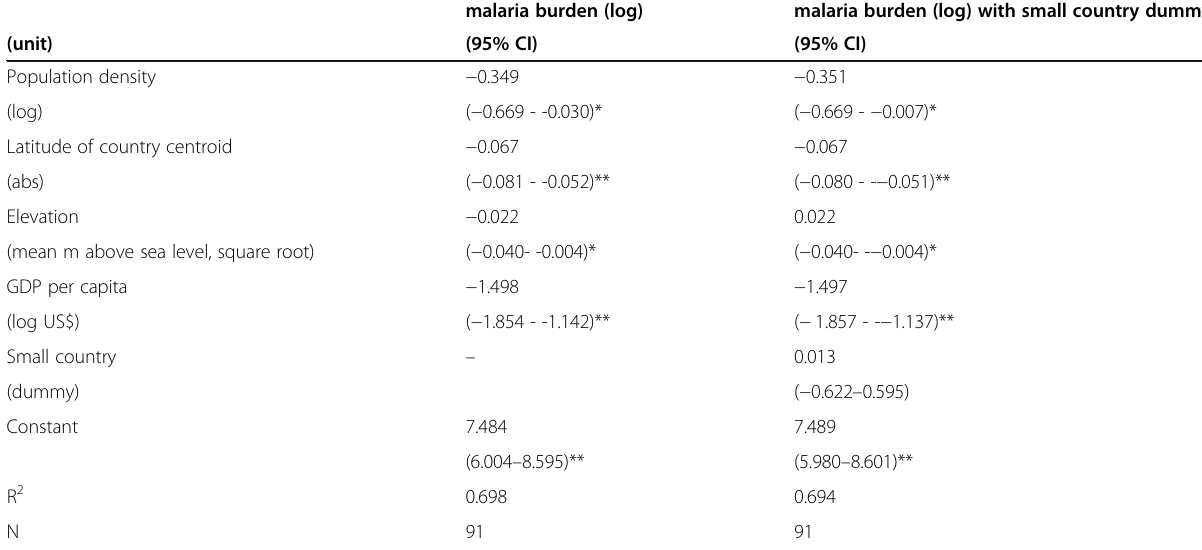
Table 4 Multiple linear regression model of malaria burden malaria burden (log) malaria burden (log) with small country dummy